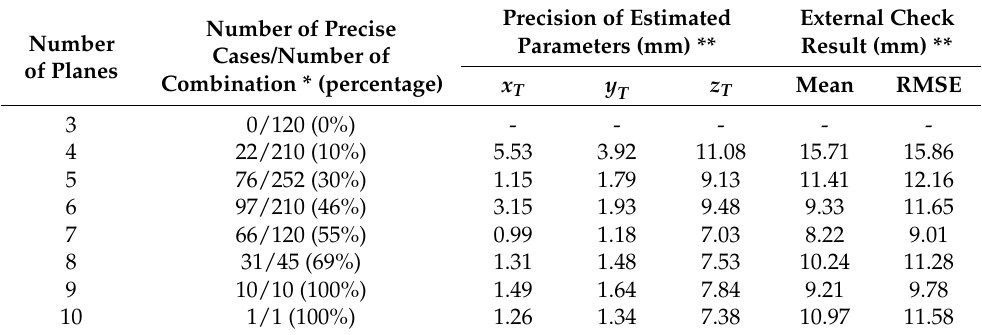
Table 8 summarized the results of applying the controlled datasets. Table 8. Precision of estimated parameter and external check result according to plane